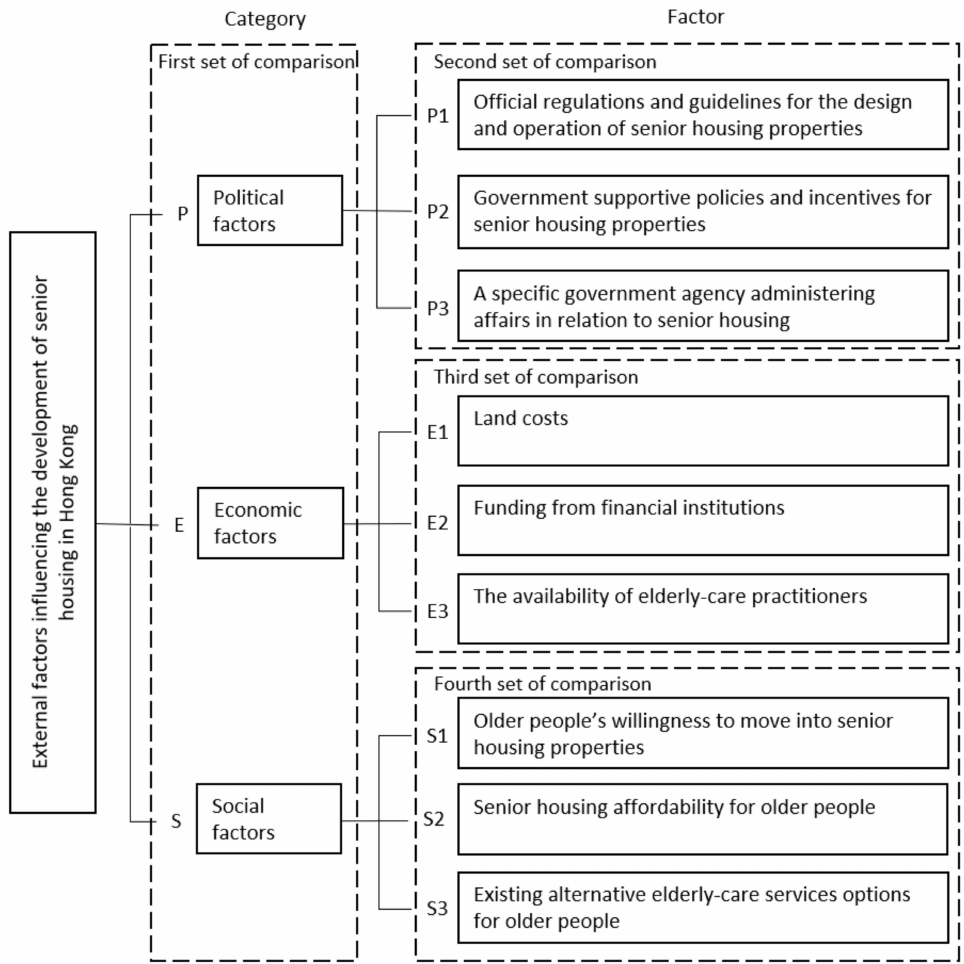
Figure A1. The hierarchical model of the reviewed factors.